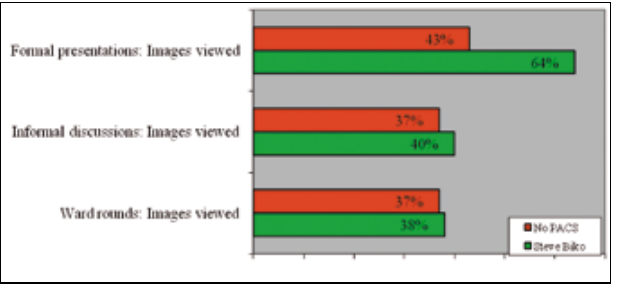
Fig. 5. Percentage of clinicians who had the opportunity to view images more than half the available teaching time at institutions without and with a PACS.